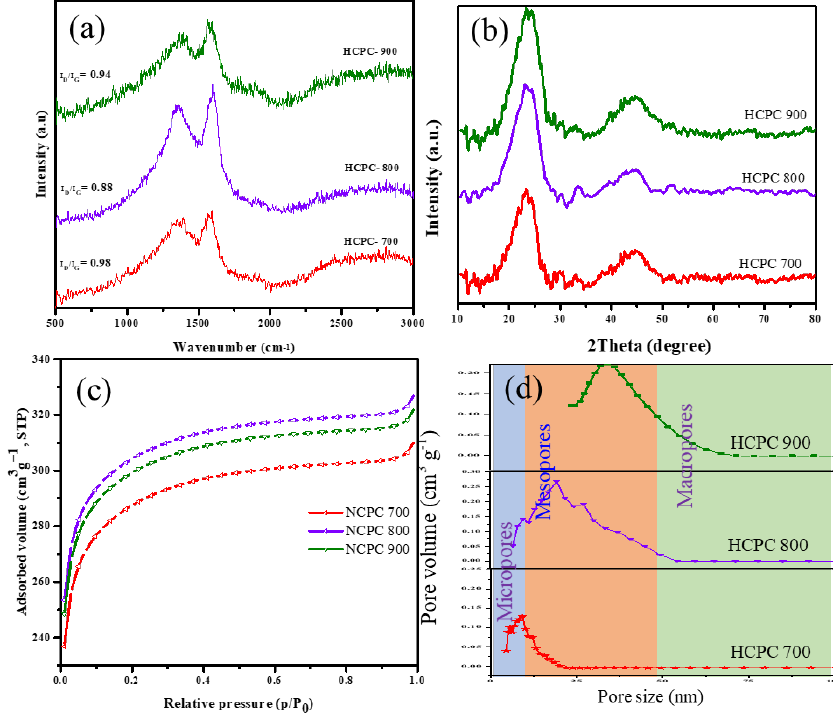
Figure 2. ( a ) Raman spectra, ( b ) XRD, ( c ) N 2 adsorption isotherms and ( d ) pore size distribution of